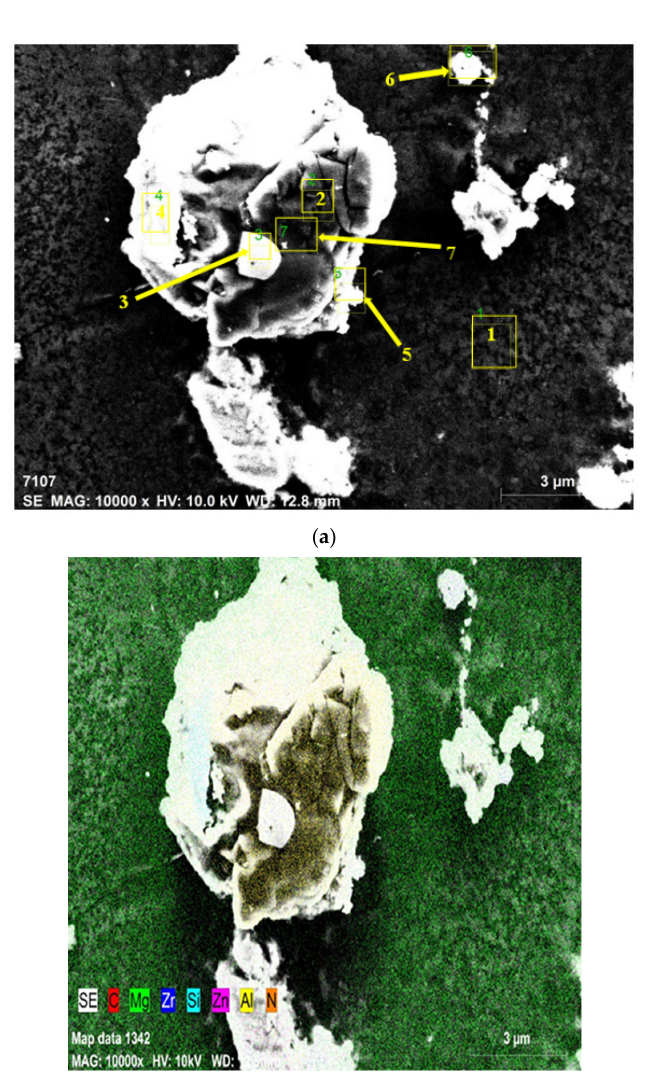
Figure 4. SEM images of the ZK60 with 15% SiC + 0.5 AIN reinforcement, ( a ) the image EDX analysis in 10 kX magnification (Shown the 7 regions for examining with EDX spectral analysis), ( b ) The elemental mapping of the EDX image in Figure 4a. Table 4. The regions’ spectral analysis findings in Figure 4a for ZK60 + 15%SiC + 0.5 AIN.